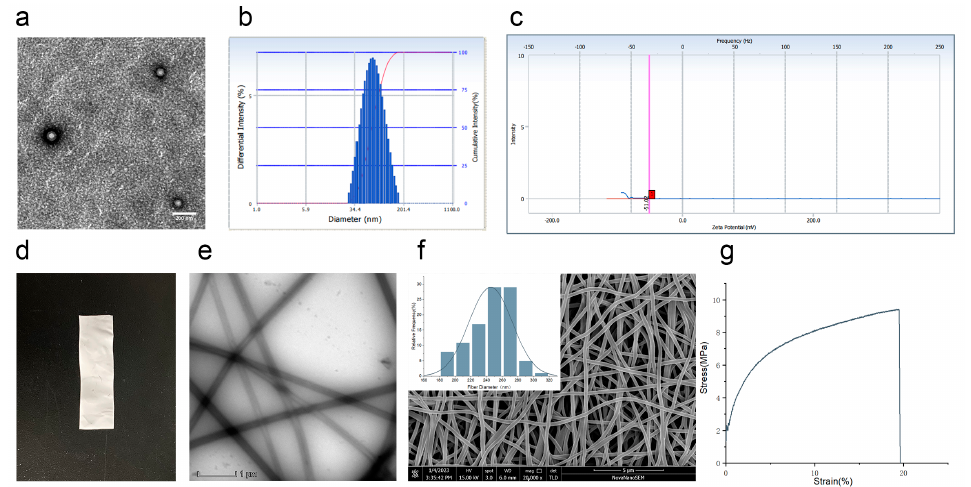
Figure 3. The characteristics of Cel-NPs-NFs; ( a ) Cel-NPs in nanofibers under a transmission electron microscope (scale: 200 nm); ( b ) Particle size distribution of Cel-NPs in nanofibers; ( c ) Potential distribution diagram of Cel-NPs in nanofibers (The red square on the x-axis is the potential value); ( d ) Cel-NPs-NFs appearance diagram; ( e ) Cel-NPs-NFs under a transmission electron microscope (scale: 1 μ m); ( f ) Cel-NPs-NFs under a scanning electron microscope and diameter distribution of 100 fibers (scale: 5 μ m); ( g ) Stress–strain curve of Cel-NPs-NFs.